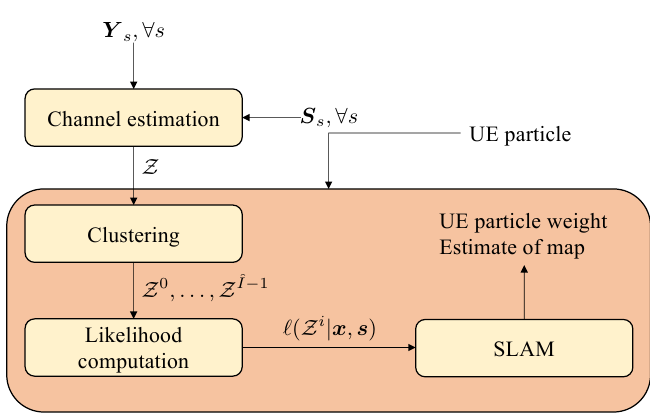
Figure 3. Proposed layered approach for SLAM from the observations Y s . The time index k is